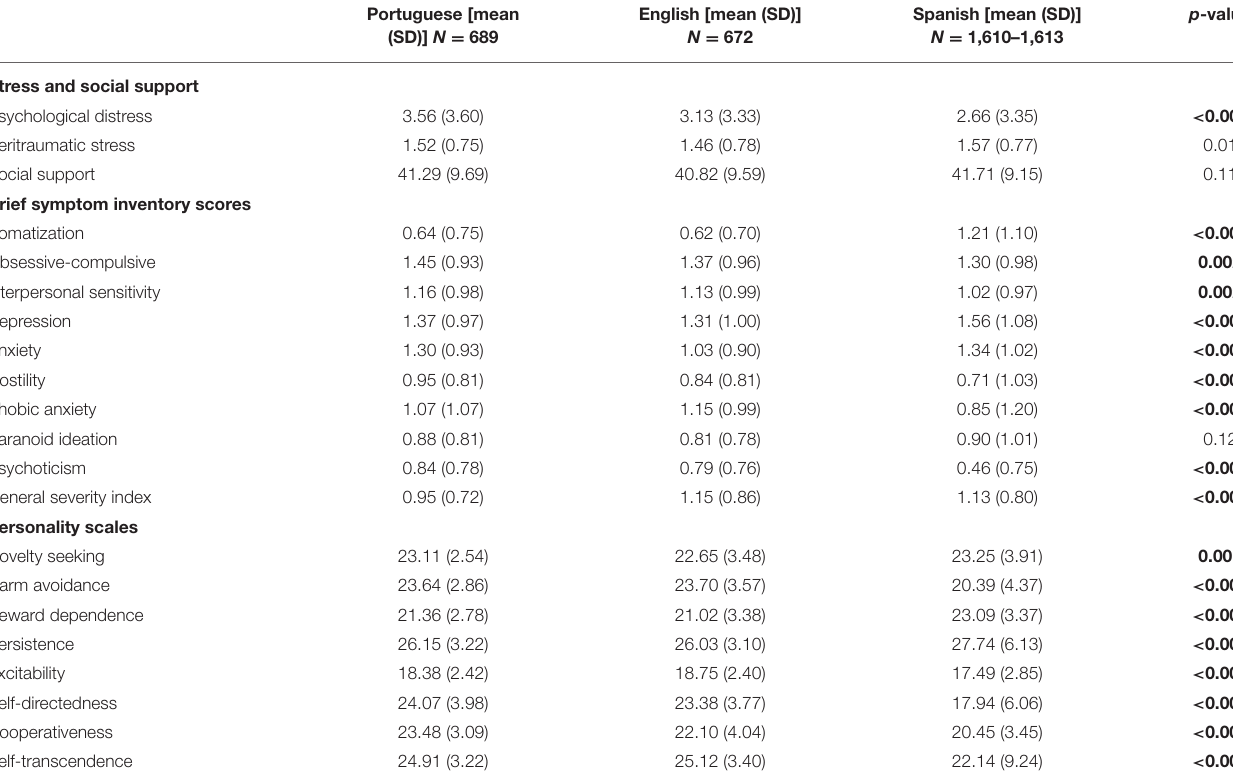
TABLE 3 | Comparing means of psychometric measures among Spanish, Portuguese, and English speakers.